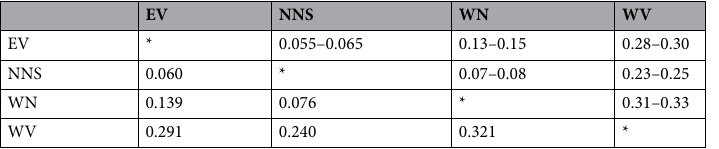
Table 3. F ST values between the four populations determined by Structure results. F ST values are below the diagonal, bias-corrected 95% confidence intervals from 1000 bootstrap replicates are above the